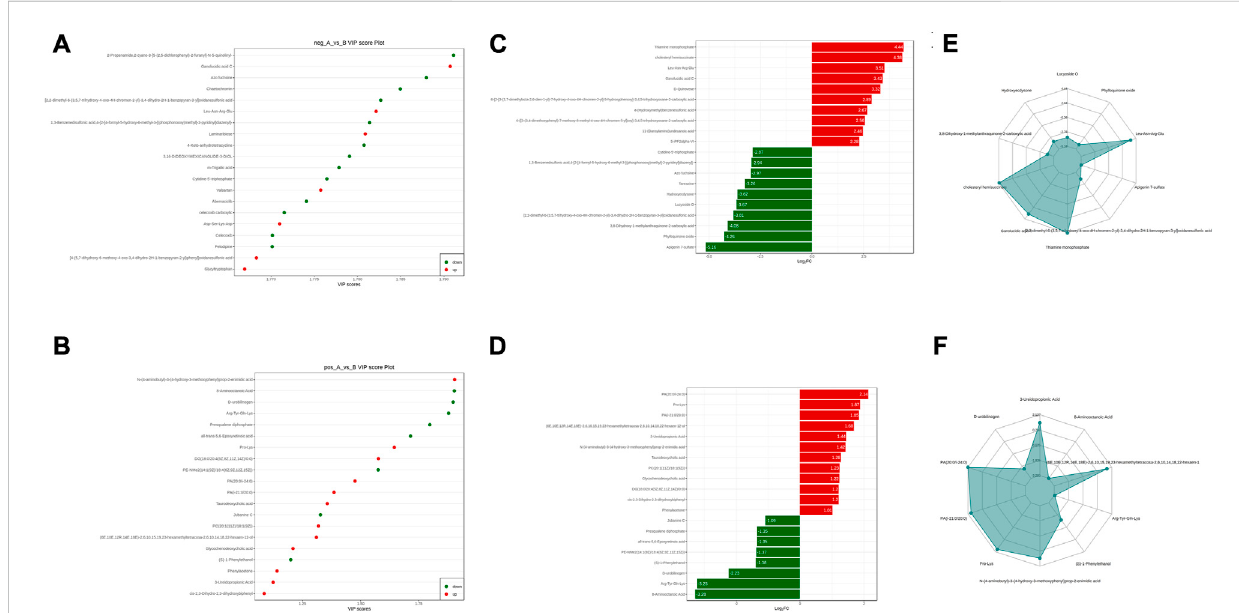
FIGURE 7 Groups A vs. B differential metabolite screening. (A) top 20 potential differential metabolites with VIP ≥ 1 under anionic conditions; (B) top 20potentialdifferentialmetaboliteswithVIP ≥ 1undercationicconditions; (C) toptendifferentialmetabolites withup-anddownregulatedploidychange values under anionic conditions; (D) top ten differential metabolites with up- and downregulated ploidy change values under cationic conditions; (E) radar plot under anionic conditions selectively showing ten representative differential metabolites with change fractions; (F) radar plot under cationic conditions selectively showing ten representative differential metabolites with change